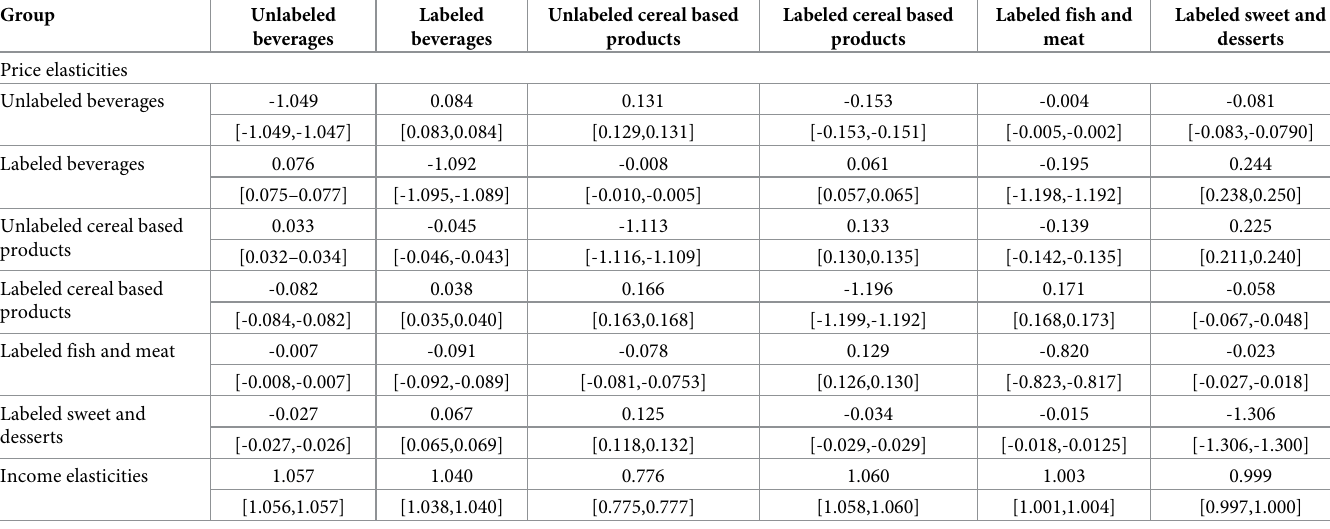
Table 2. Own, cross price elasticities and expenditure elasticities for food and beverages 2015–2017 (AIDS model).